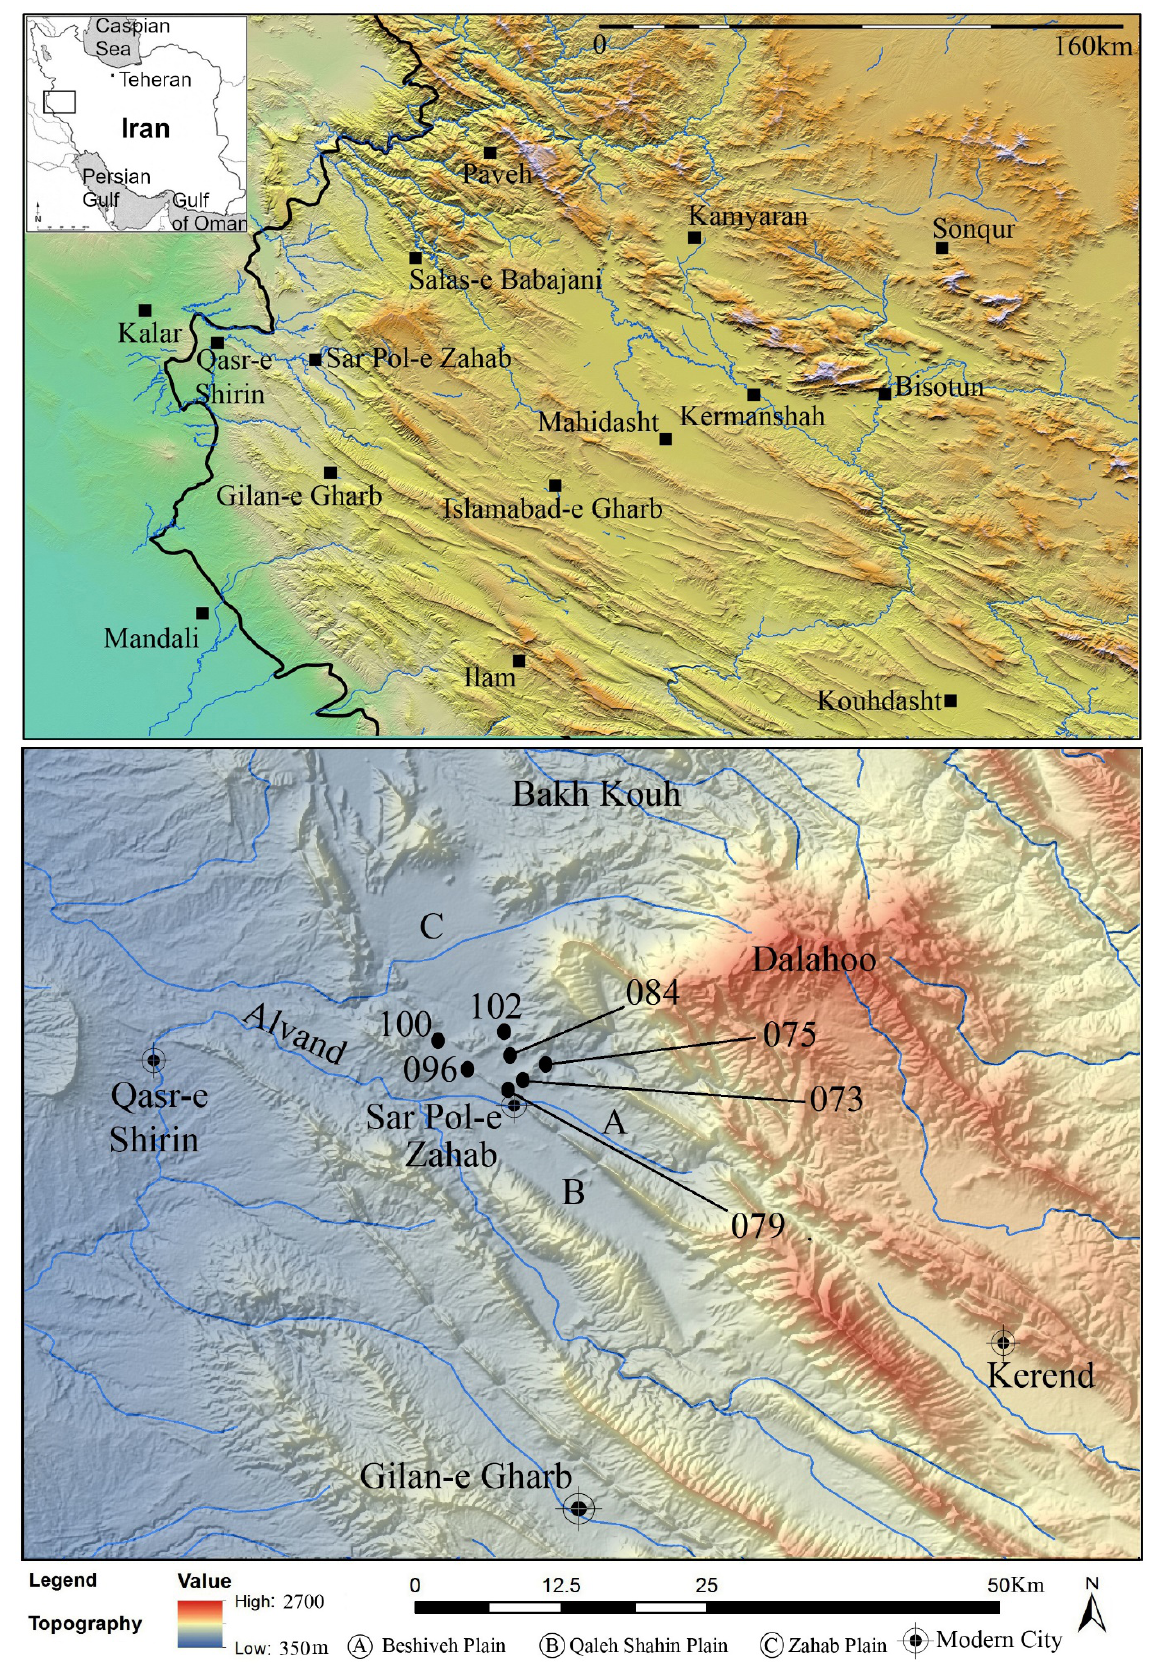
Figure 2. The location of Sar Pol-e Zahab and sites with rock mortars (courtesy of Hamzeh Qubadizadeh and Saman